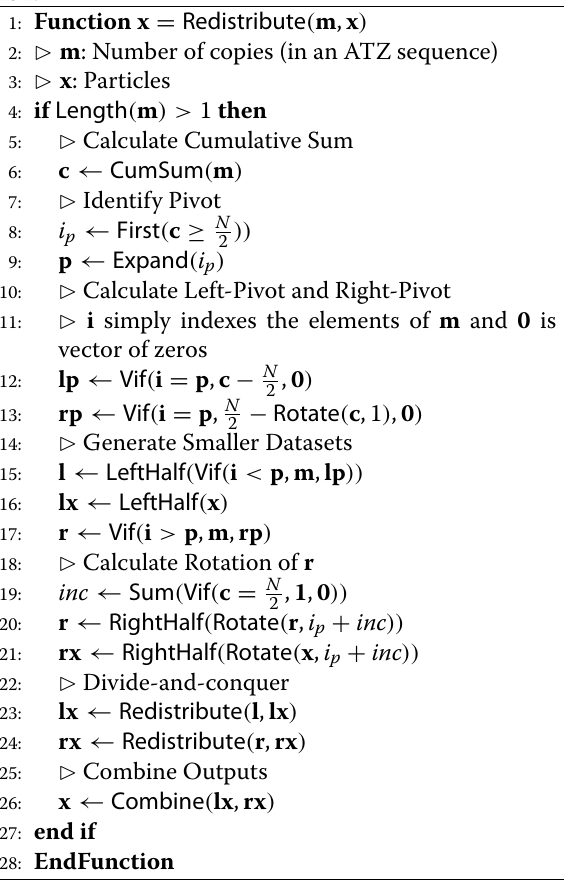
(cid:2) (cid:3) ( log N N ) 2 implementa- 2 P